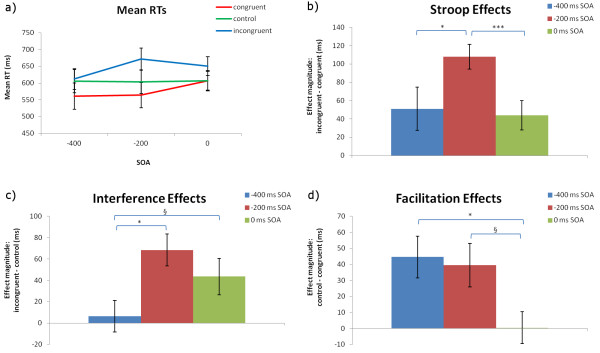
Behavioural data. a) Mean RTs for each congruency and SOA (standard error in parentheses). b) Stroop; c) interference; and d) facilitation effects, with significant differences between SOAs, as determined by paired-sample t-tests (two-tailed), indicated (§ = trend, p < 0.1; * = p < 0.05; ** = p < 0.01; *** = p < 0.001).